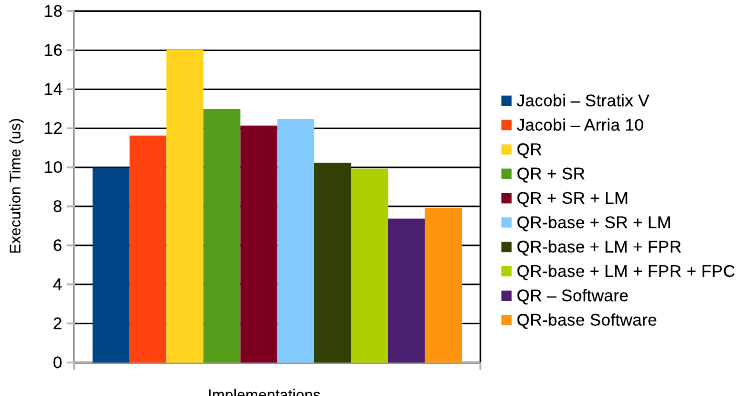
Figure 4. Execution time for each design implementation.